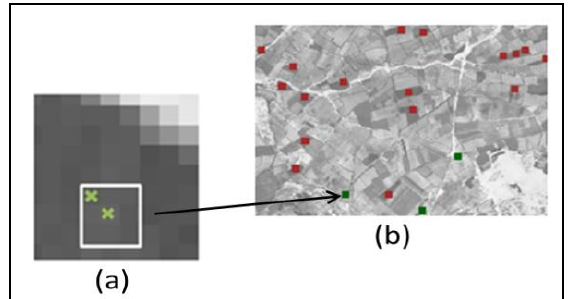
Figure 2: Illustration of a grid of 3 x 3 pixels centered on a sampled semi-vegetated site. Green crosses are the central pixel for which clay content is known and a neighbour pixel.